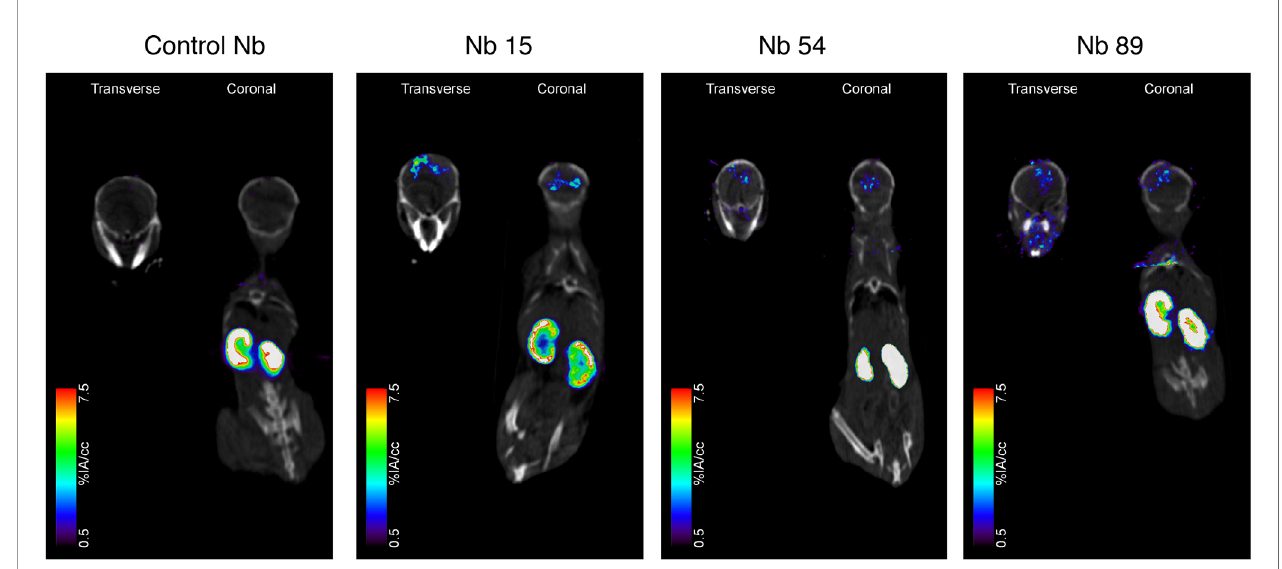
FIGURE 3 | Anti-SIRP a Nb15 targets mouse GL261 GBM tumors in vivo . Fused pinhole SPECT/micro-CT images of GL261 tumor-bearing mice injected with 99m Tc-labeled “ anti-SIRP a Nb clones 15, 54 and 89 or a non-targeting control Nb R3B23. Mice were imaged 1 hour post injection. Transverse and coronal views are shown, with slices chosen to pass through the brain tumor, without taking other organs into account. Slices that explicitly go through other organs are shown in Supplementary Figure 3 . Results are representative of n = 3 mice for each